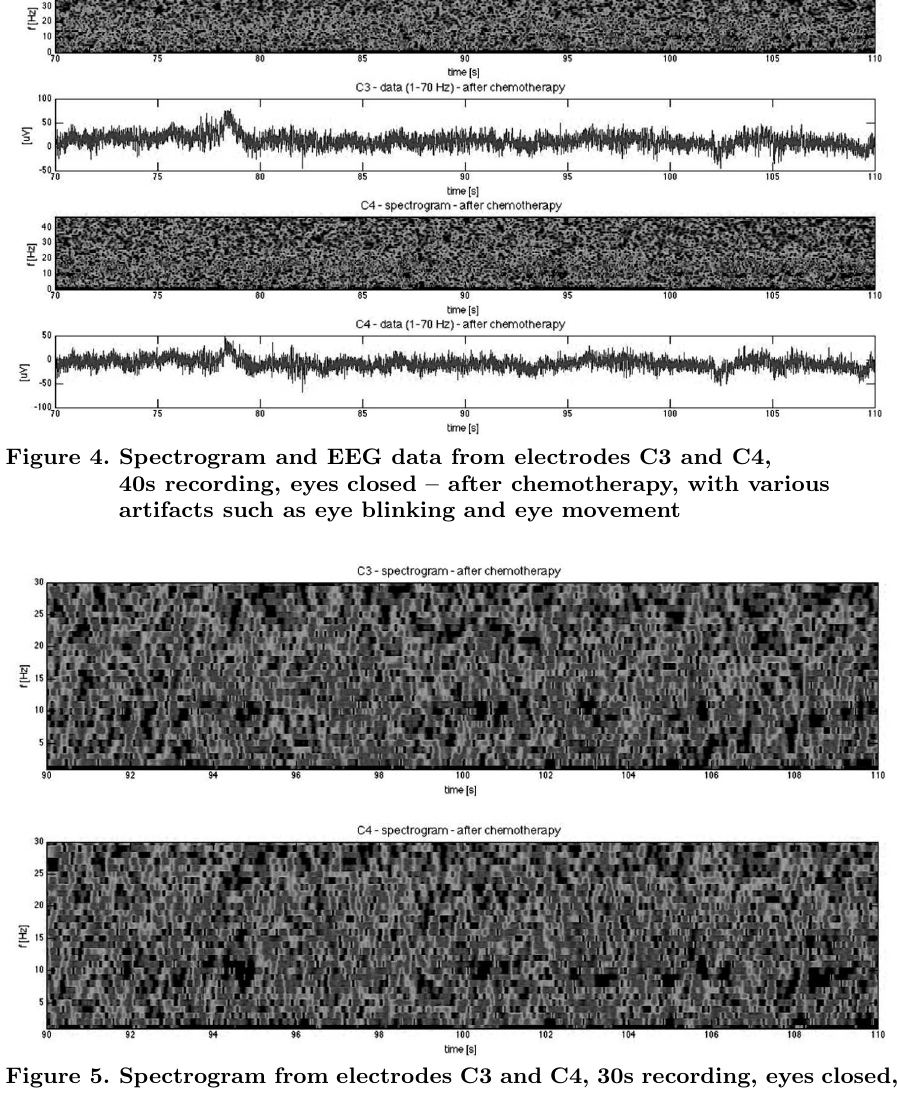
Figure 5. Spectrogram from electrodes C3 and C4, 30s recording, eyes closed, a close-up – after chemotherapy with various artifacts such as eye blinking and eye